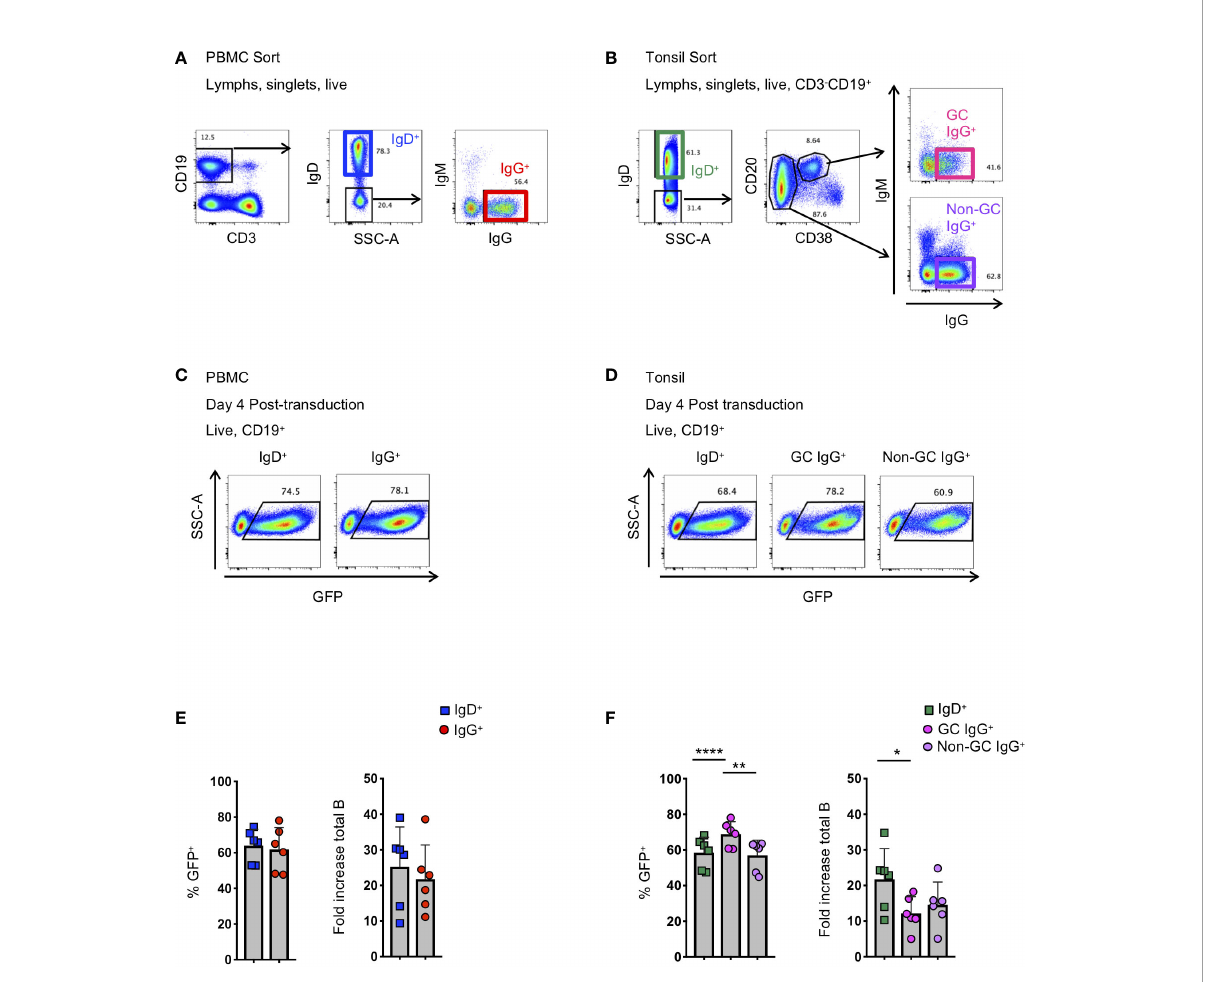
FIGURE 1 Activation and transduction of B cell subsets from PBMC and tonsil. (A, B) Flow cytometry sorting schematic for the isolation of indicated B cell populations from PBMC (A) and tonsils (B) . (C, D) Representative fl ow plots used to determine the frequency of GFP+ cells 4 days after transduction in populations from PBMC (C) and tonsil (D) . (E, F) Frequency of GFP+ B cells 4 days post-transduction (left panel) and the fold- increase in total B cell number (right panel) during activation and transduction of isolated PBMC populations (E; n=6) and of isolated tonsil populations (F; n=6). Signi fi cant differences were determined by paired t-tests for PBMC populations and one-way ANOVA with Tukey's multiple comparisons test for tonsil populations. ****p<0.0001; **p<0.005;